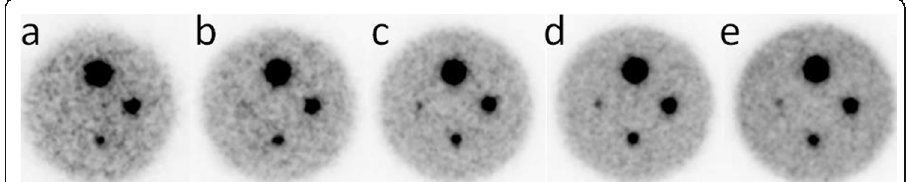
Fig. 3 Images of the breast phantom scanned by dbPET at the five different positions. Images a , b , c , d , and e correspond to phantom images scanned at 8 mm, 13 mm, 19.5 mm (depth of 1/8), 39 mm (depth of 1/4), and 78 mm (depth of 1/2, the centre of the detector) below the top edge of the detector. Closer to the edge of the detector, the background was noisier. The hot spots of the smallest sphere with a diameter